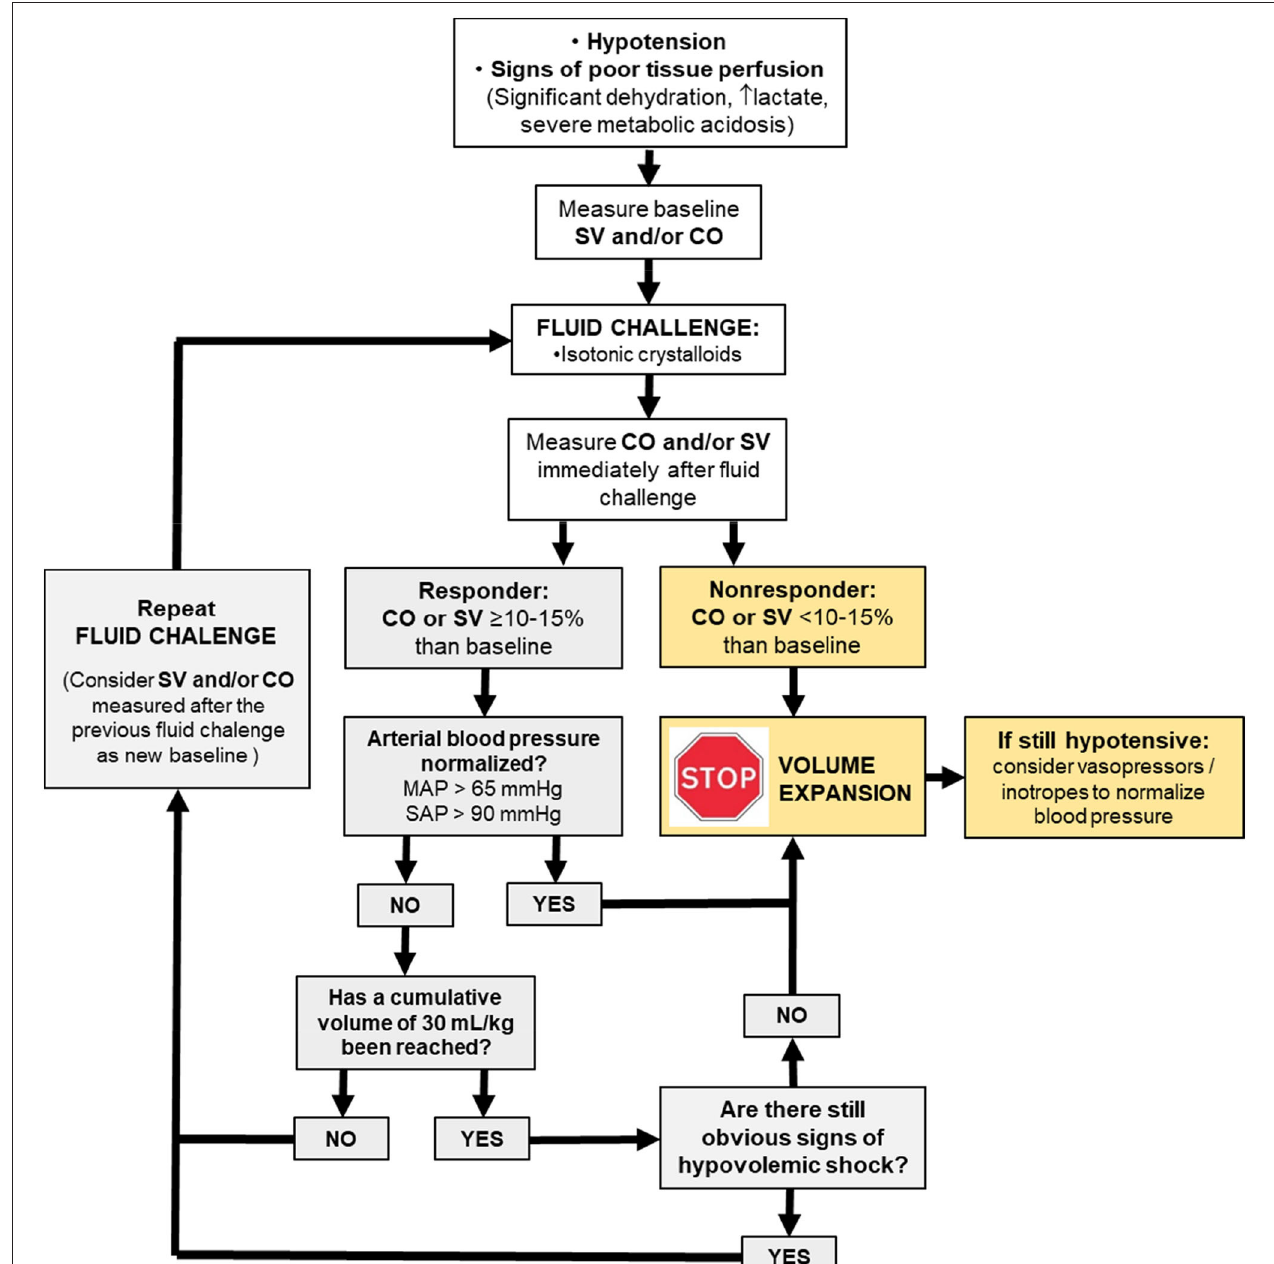
the volume of intravenous fluids should be initially